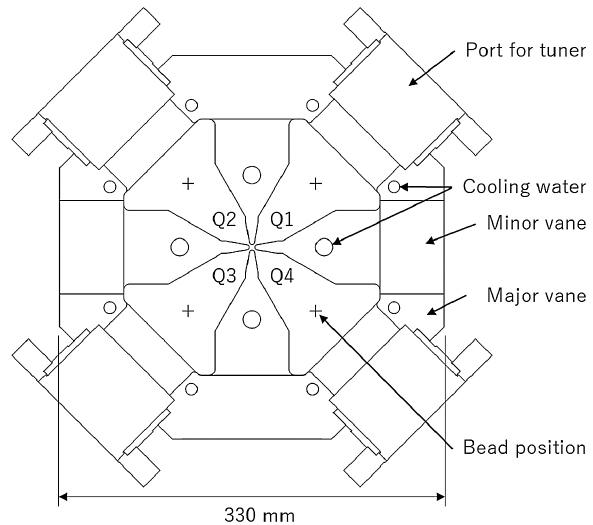
FIG. 7. Cross-sectional view (from upstream) of the epRFQ